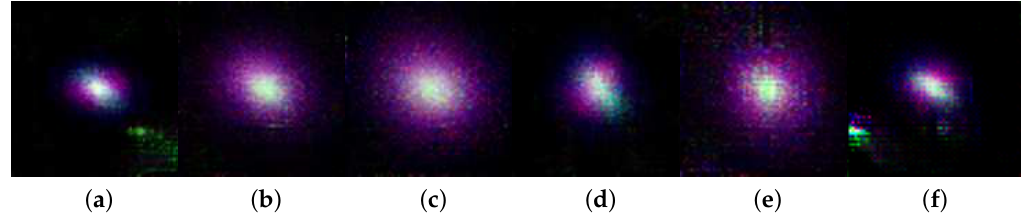
Figure 11. Generated images of bearing fault data using the DCGAN. ( a ) Contaminant, ( b ) outer high, ( c ) outer medium, ( d ) outer low, ( e ) inner high, and ( f ) inner